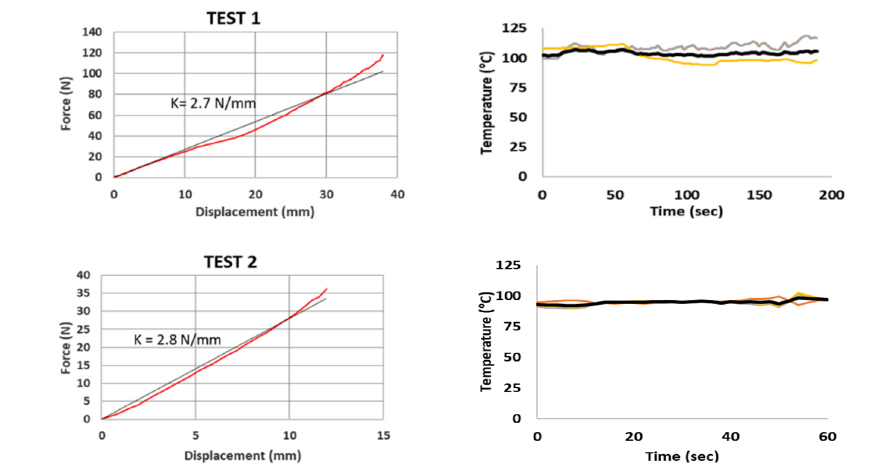
Figure 13. Electric resistance band used as a heating system.